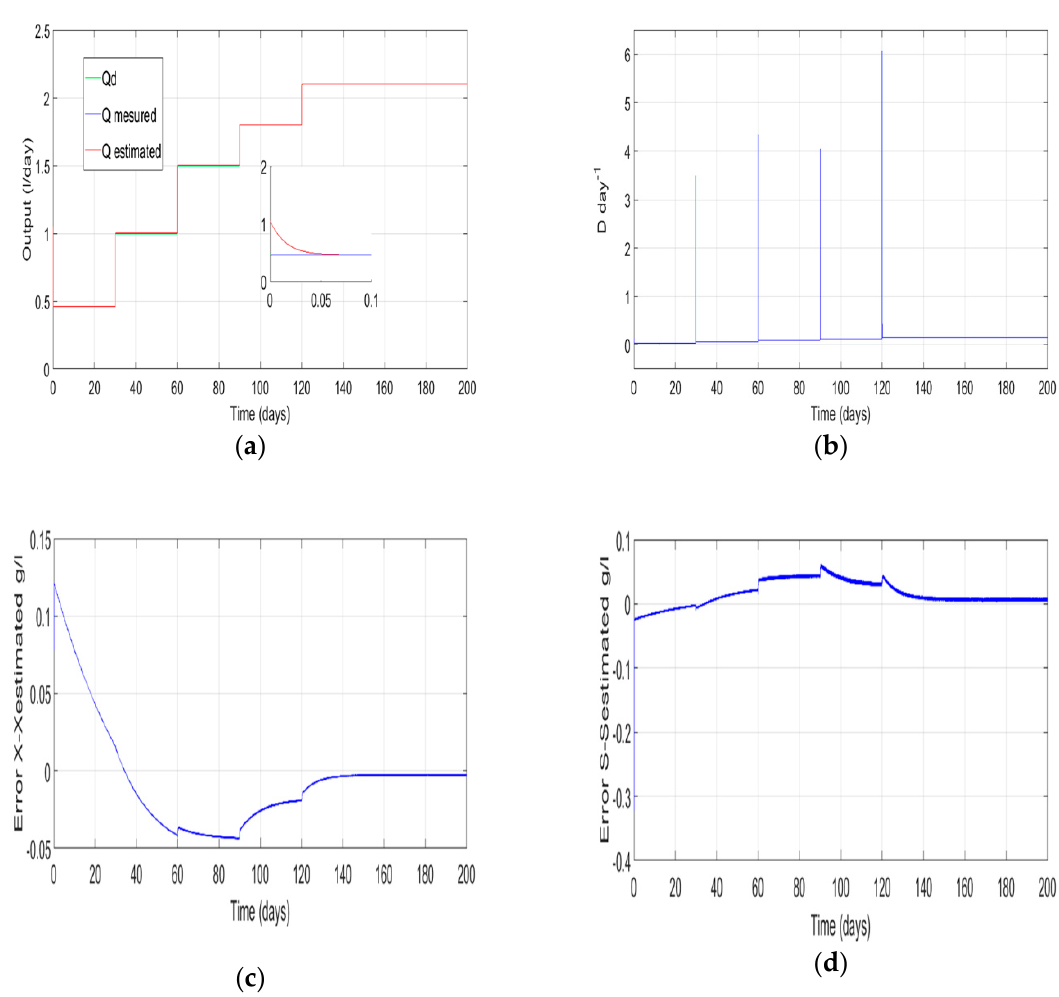
Figure 6. Anaerobic digestion first order sliding mode observer based synergetic controller. ( a ) Biogas flow rate; ( b ) control signal evolution; ( c ) estimation error of the concentration of the bacterial population X ; ( d ) estimation error of the concentration of the substrate S . c) Sliding mode observer with PD based surface based synergetic control.